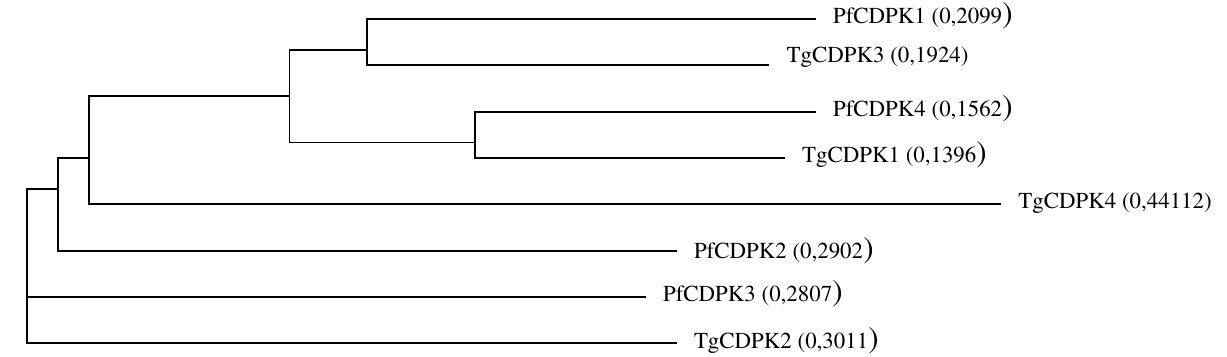
Fig. 2. – Phylogenetic tree showing the relationship between Toxoplasma gondii and Plasmodium faciparum CDPKs were generated using Vector